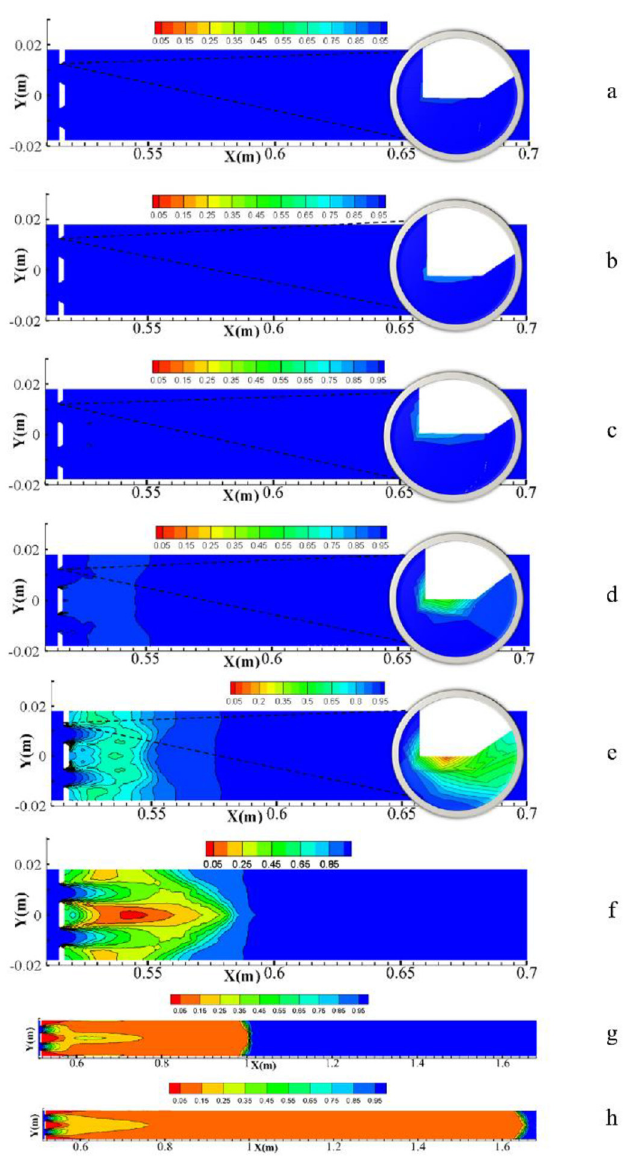
Fig. 21. The contour of cavitation volume in multi-hole ori fi ce with EDR=0.4 and in the fl ow of (a) 14 (b) 16 (c) 18 (d) 20 (e) 22 (f) 24 (g) 25 (h) 26 m 3 /h.